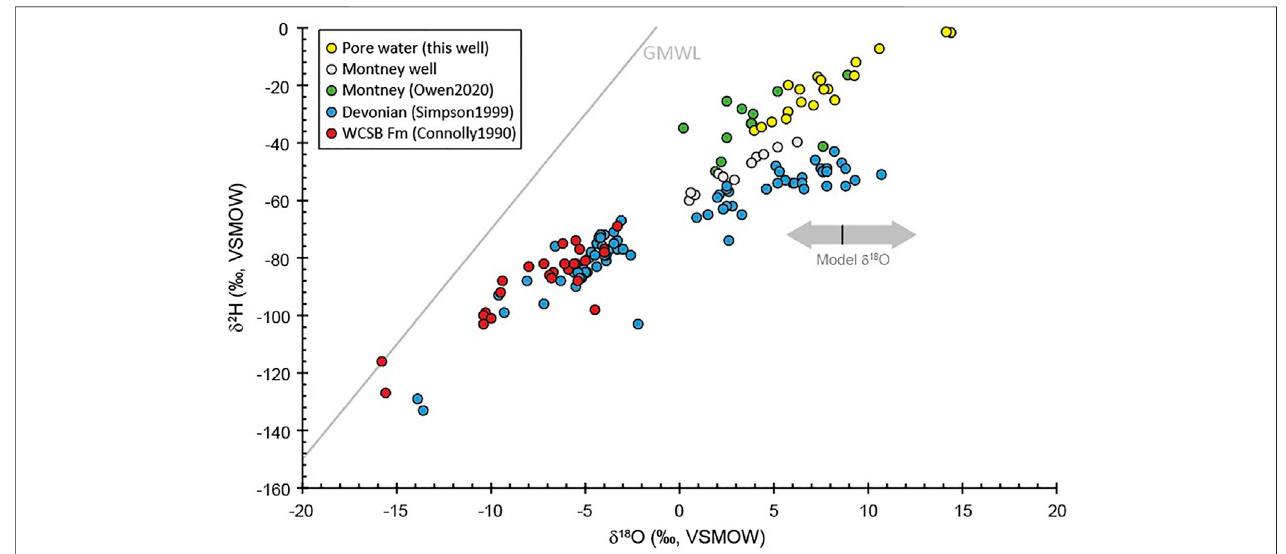
FIGURE14| StableisotopevaluesfromWesternCanadianSedimentaryBasin(WCSB)formationwatersandmodeledwaterfromMontneyverticalfracturecalcite. Isotope analysisfromthiswell(yellow)and anotherMontneywell(grey)arefrompore watersextracted fromcores.MontneywatersfromOwenetal.(2020)werederived from fl owback waters. WCSB Fm. waters (Connolly et al., 1990) include Devonian, Mississippian, Jurassic, and Cretaceous formation waters, but dominantly Mesozoic formation waters.